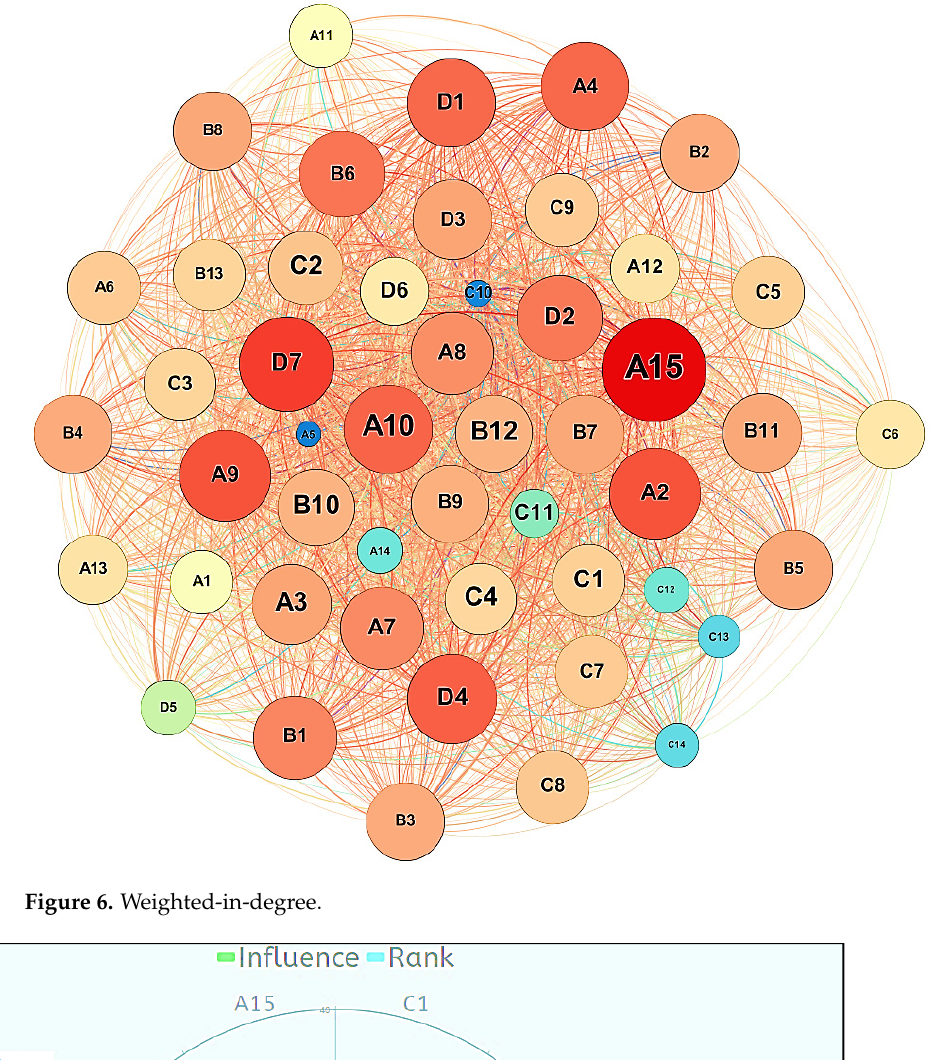
Table 5. The position of each factor in the influence-dependence map.